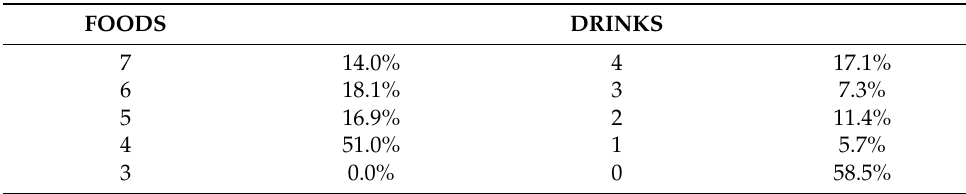
Table 4. Textures of foods and drinks after dysphagia and nutritional status assessment: IDDSI framework; relative frequencies (%).